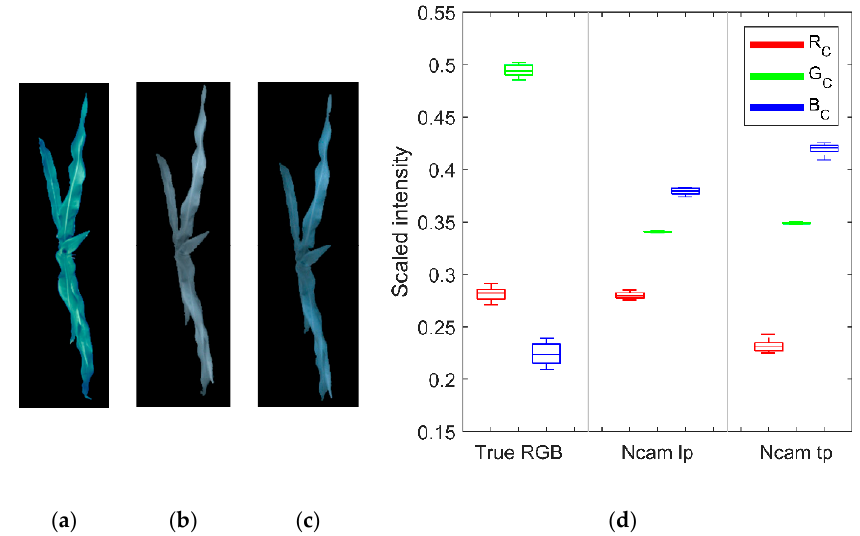
Figure 4. The boxplot of the corn plants raw dataset from Ncams and HSC after calibration with the whiteboard.